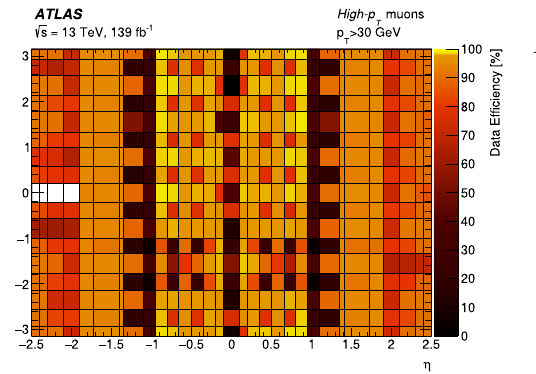
Fig. 15 Reconstruction and identification efficiency measured in col- lision data (left), and the data/MC efficiency scale factor (right) for High - p T muons as a function of η and φ for muons with p T > 30 GeV